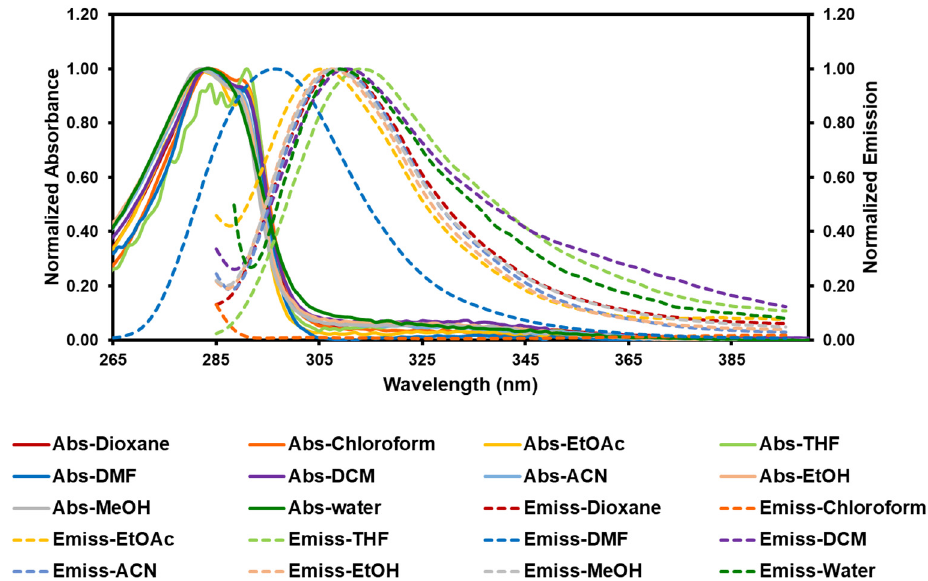
Figure 5. Normalized UV absorption and emission spectra of the benzoxazine (I) in various solvents. Table 3. Photophysical properties of the benzoxazine (I) in various solvents. Solvent